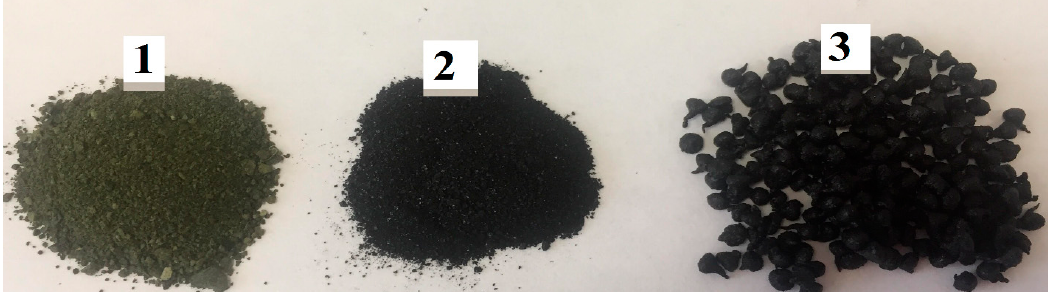
Figure 7. External view of: 1—residual biomass of microalgae C. sorokiniana; 2—thermally-treated residual biomass of microalgae C. sorokiniana; 3—granular thermally-treated residual biomass of microalgae C. sorokiniana with chitosan.